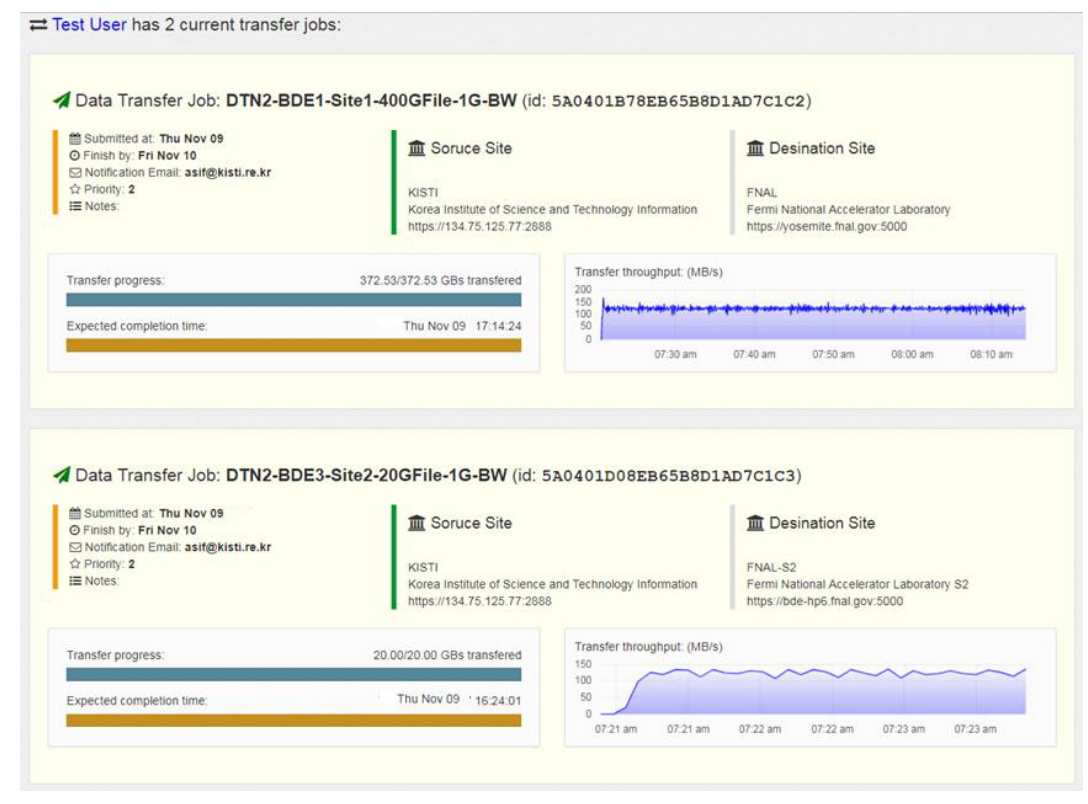
Figure 9. Evaluation results of the parallel submitted tasks.